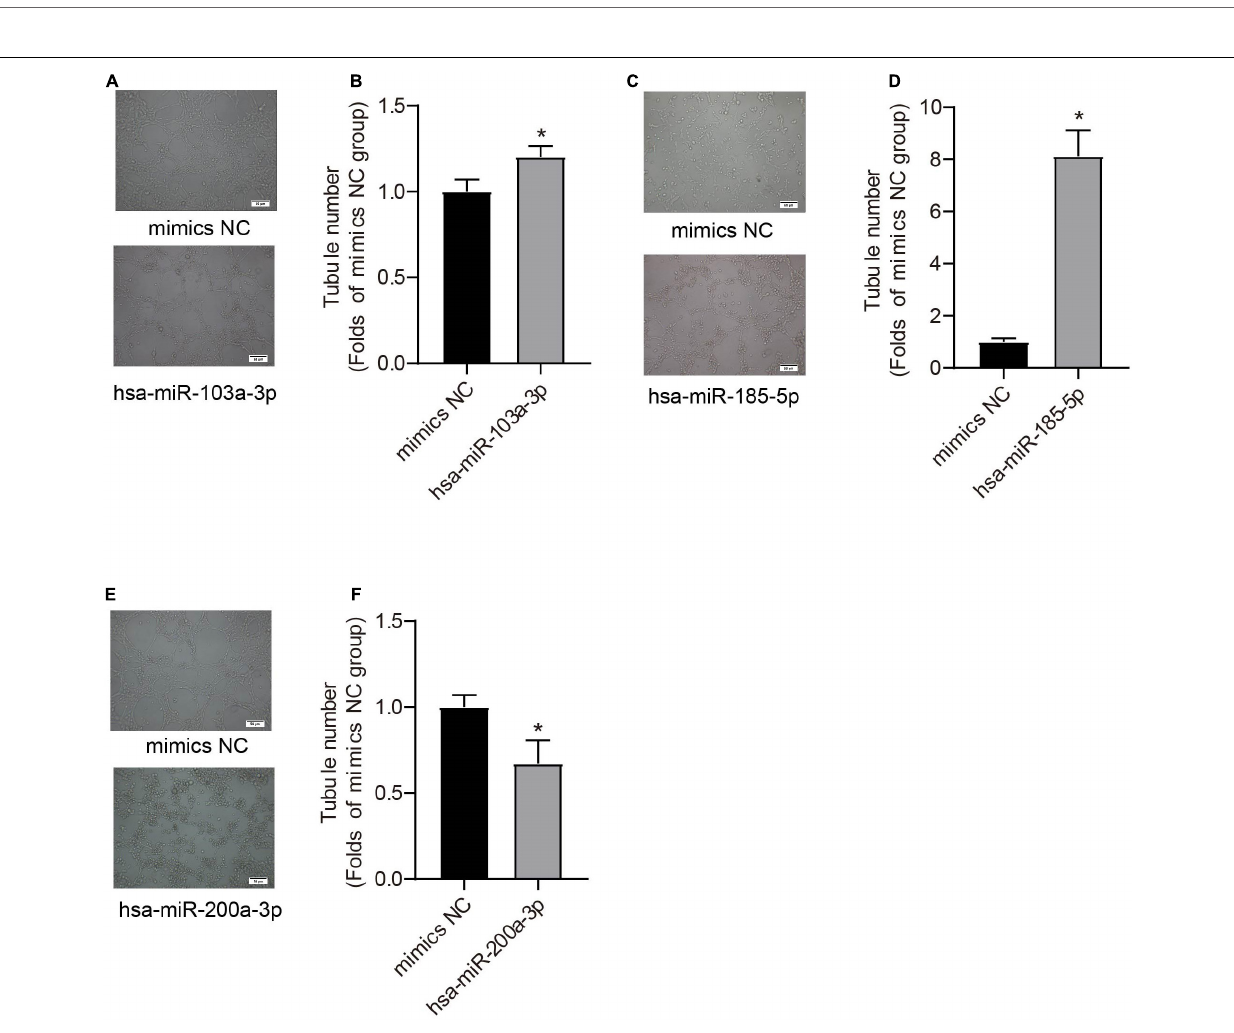
FIGURE 7 | Effects of hsa-miR-103a-3p, hsa-miR-185-5p, and hsa-miR-200a-3p mimics on endothelial tube formation. Tube formation was determined at 48 h after miRNA mimic transfection. Hsa-miR-103a-3p (A,B) and hsa-miR-185-5p (C,D) overexpression increased endothelial tube formation, whereas hsa-miR-200a-3p overexpression (E,F) reduced tubule number. * P < 0.05, versus mimics NC group. n = 3.